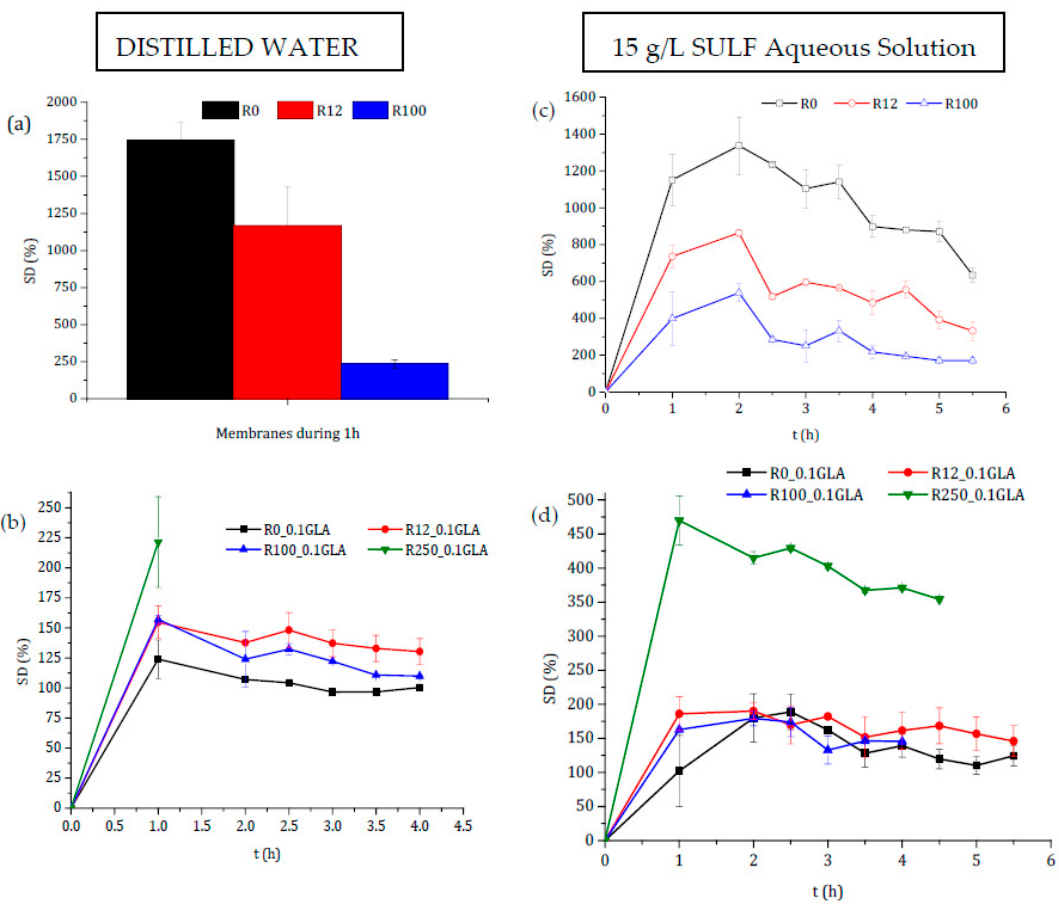
Figure 8. Degree of swelling in distilled water ( a , b ) and in 15 g/L sulfamerazine sodium salt (SULF) aqueous solution ( c , d ) of the membranes prepared with non-irradiated and irradiated chitosan at different doses: ( a , c ) without GLA and ( b , d ) with 0.1 wt % GLA in the chitosan solution.